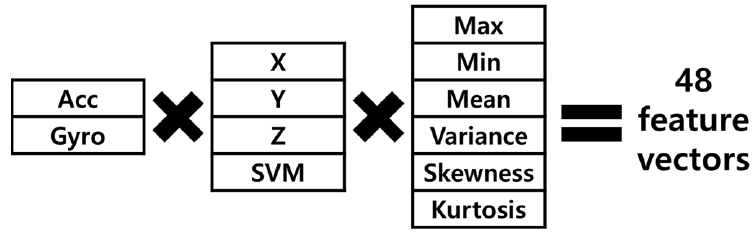
Figure 3. Feature vectors for this study.